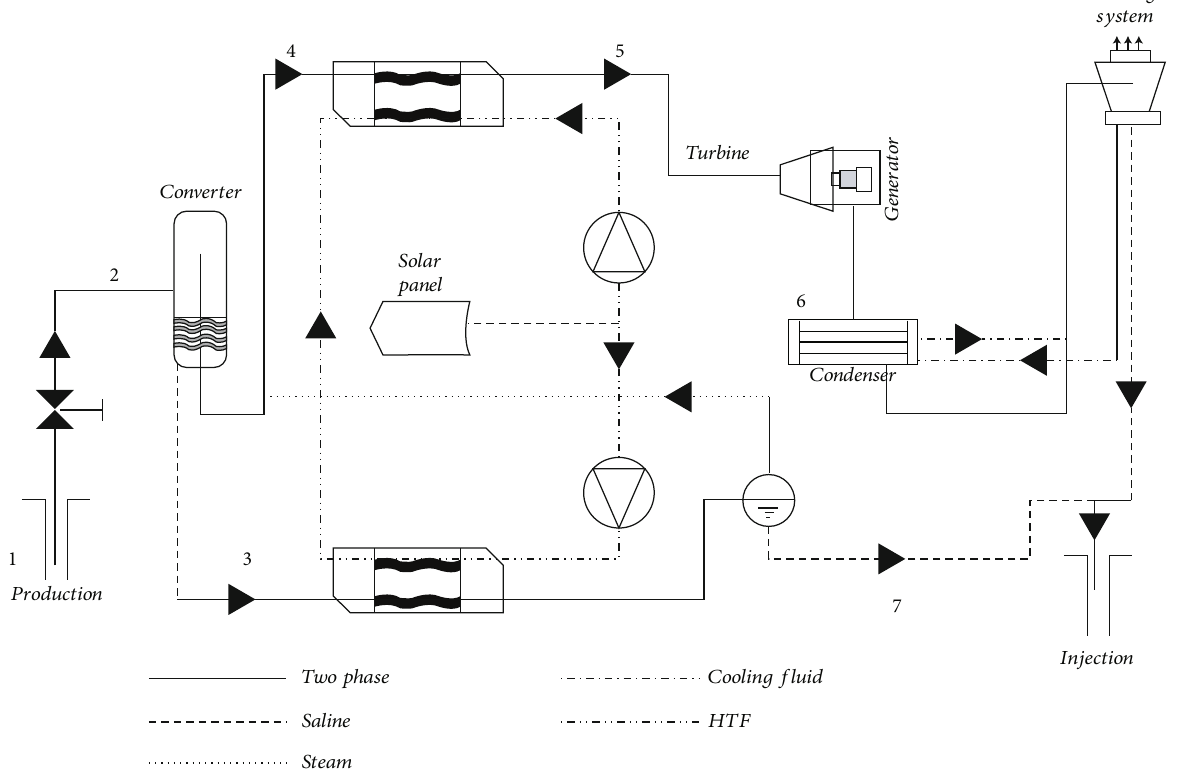
Figure 1: Schematic model of geothermal and solar power.